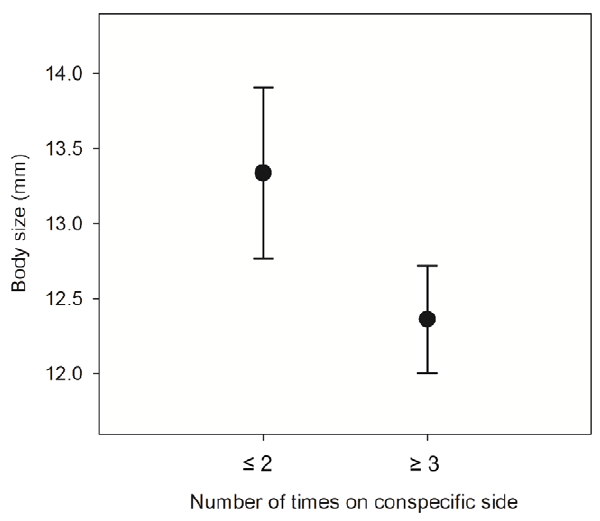
Figure 3. Mean ( ± SE) tadpole body size in relation to social preference. Body sizes (snout-vent lengths) are shown as untrans- formed data.